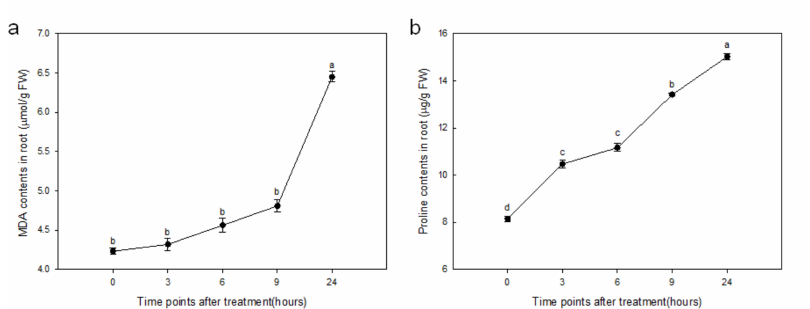
Figure 1. Changes in malondialdehyde (MDA) ( a ) and proline ( b ) contents of sorghum root in response to Polyethylene Glycol (PEG) simulated drought stress (two-week-old seedlings treated with 10% PEG-6000). Data are presented as mean ± SD ( n = 3). Di ff erent letters indicate statistically significant di ff erences at p < 0.05.